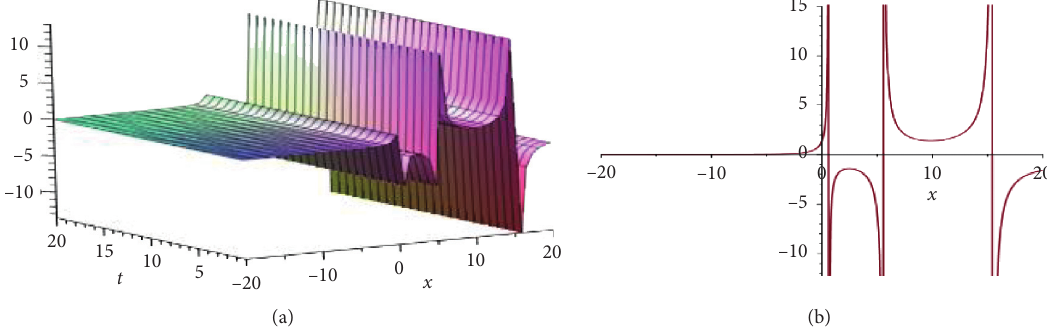
Figure 3: Singular periodic wave shape of (104) when β � 1, k � 1, c � − 1, λ � 1, α � 0 . 5, − 20 ≤ x ≤ 20, and 0 ≤ t ≤ 20.